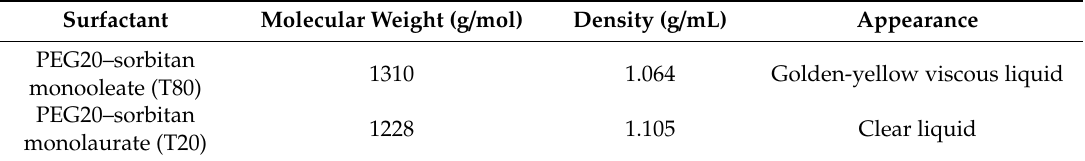
Table 1. Physical properties of the polysorbate surfactants used in this